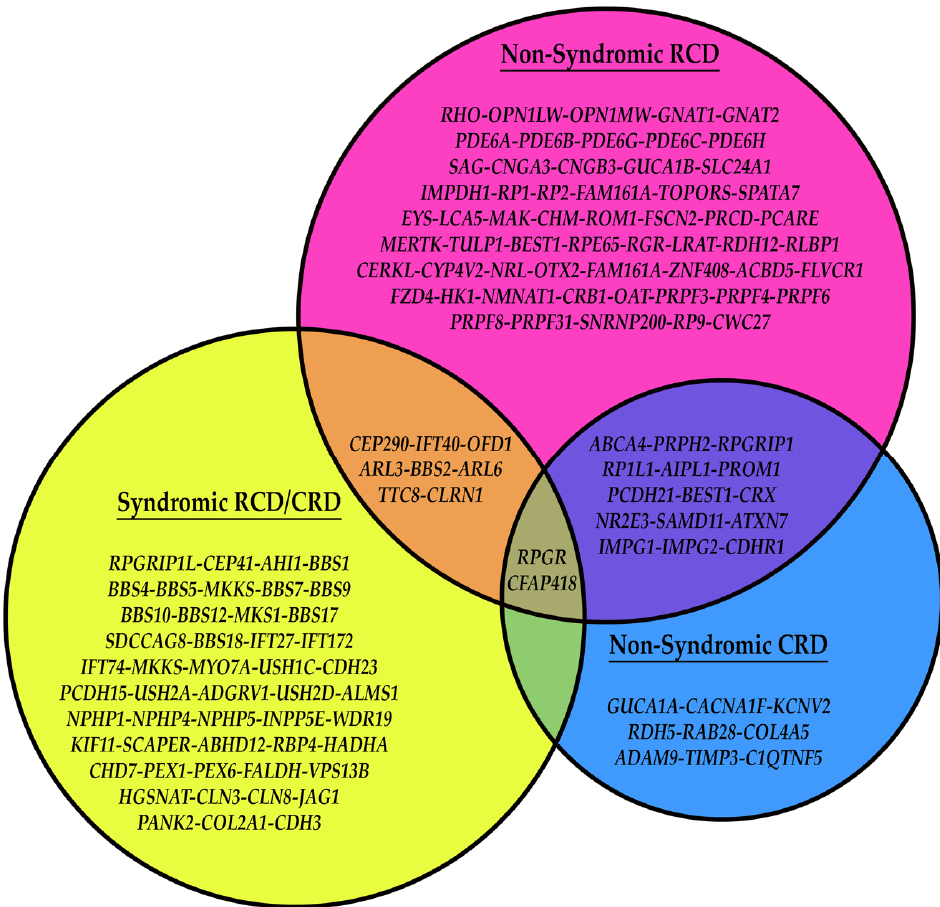
Figure 5. Venn diagram representation of the overlap of genes between different forms of inherited retinal dystrophies (IRDs). While hundreds of genes may cause a form of IRD, including non-syn- dromic rod-cone dystrophies (RCDs, magenta), non-syndromic cone-rod dystrophies (CRDs, blue), or syndromic RCDs/CRDs (yellow), several genes can result in more than one form when mutated (non-syndromic RCDs and syndromic RCDs/CRDs, orange; non-syndromic CRDs and syndromic RCDs/CRDs, purple; non-syndromic RCDs, non-syndromic CRDs and syndromic RCDs/CRDs, light brown), all dependent on the mutation and its effects. Note the overlap between the different groups consists of primarily ciliopathy genes among non-syndromic RCDs/CRDs and syndromic RCDs/CRDs and retinal function and development genes overlapping between the non-syndromic RCDs and non-syndromic CRDs. Other genes causing IRD through a syndromic form have been linked to Usher syn- drome, which results in both RP and typically deafness and presents as one of three types (USH1, 2, or 3). MYO7A (or USH1B ) is a known Usher-associated gene that encodes for unconventional myosin VIIa. This protein is localized in the apical region of the RPE and the ciliary membrane of the photoreceptors. Its function lies in the apical localization of